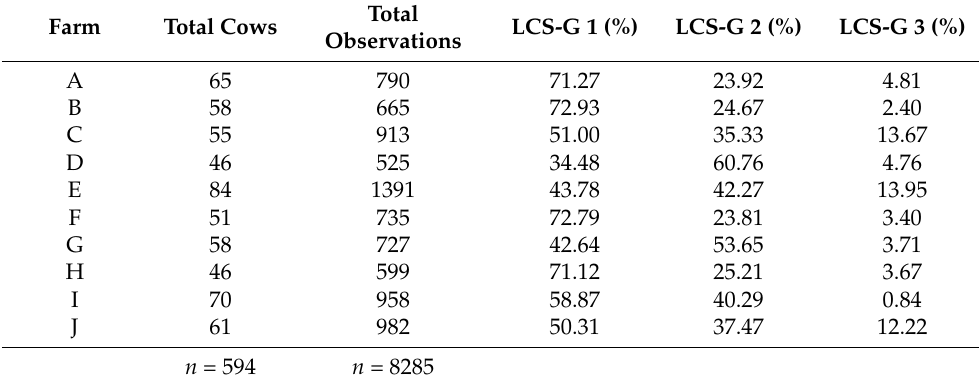
Table 5. Lameness incidence risks according to the ten farms; LCS-G 1–3: locomotion score groups 1 to